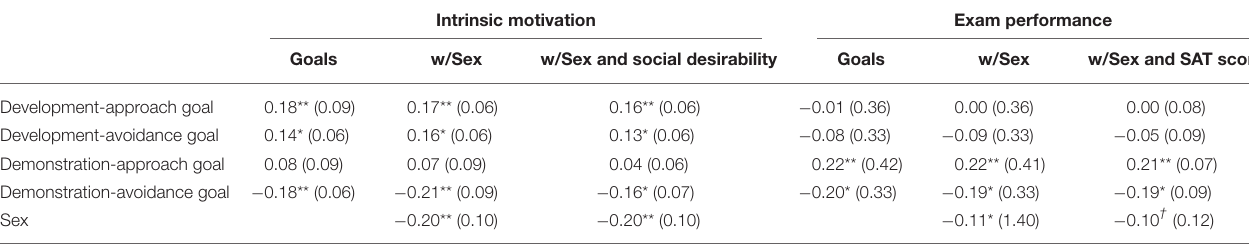
TABLE 4 | Studies 2 and 3: Beta coefficients and standard errors from simultaneous regression analyses.